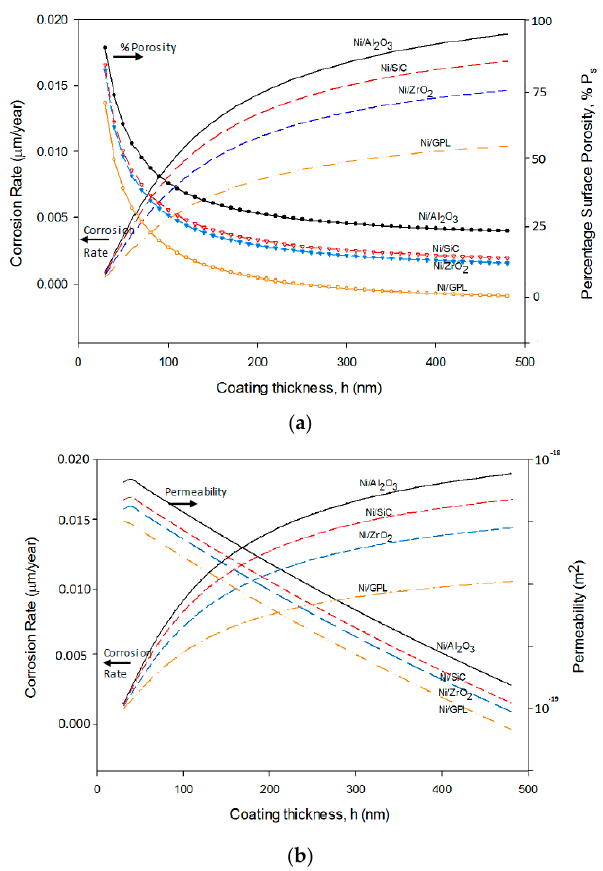
Figure 8. The predicted corrosion rates with respect to coating thickness as a function of ( a ) surface porosity and ( b ) permeability.